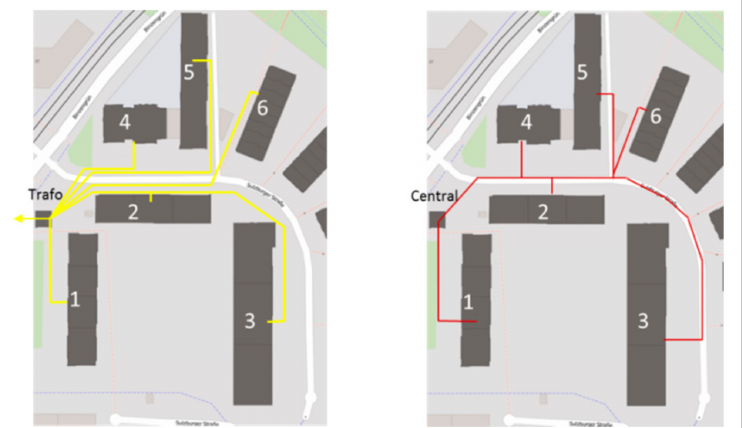
Figure 3. Model region including electricity grid, demand regions, and spot market connection area ( left ) and heating grid, demand regions, and central region ( right